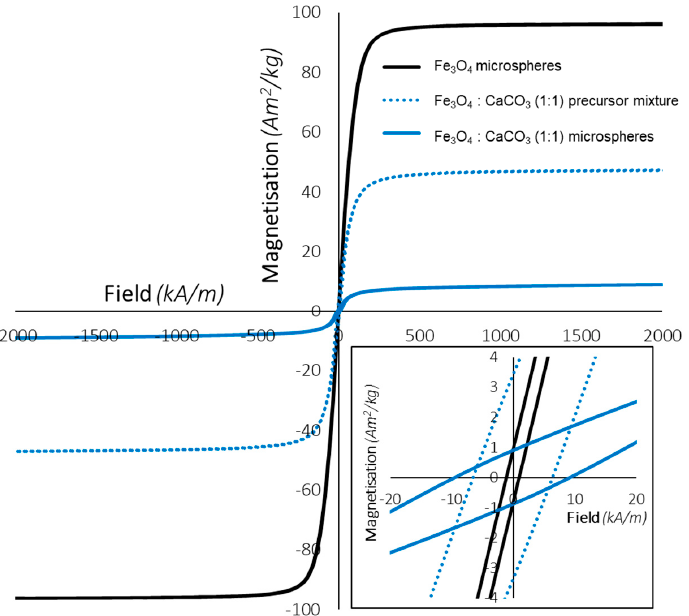
Figure 7. Hysteresis loop measurements for flame-spheroidised Fe 3 O 4 microspheres, compared to Fe 3 O 4 :CaCO 3 (mass ratio 1:1) precursor powders and microsphere products, at 26.85 °C. Inset fi gure provides evidence of remanent magnetisation in all cases.